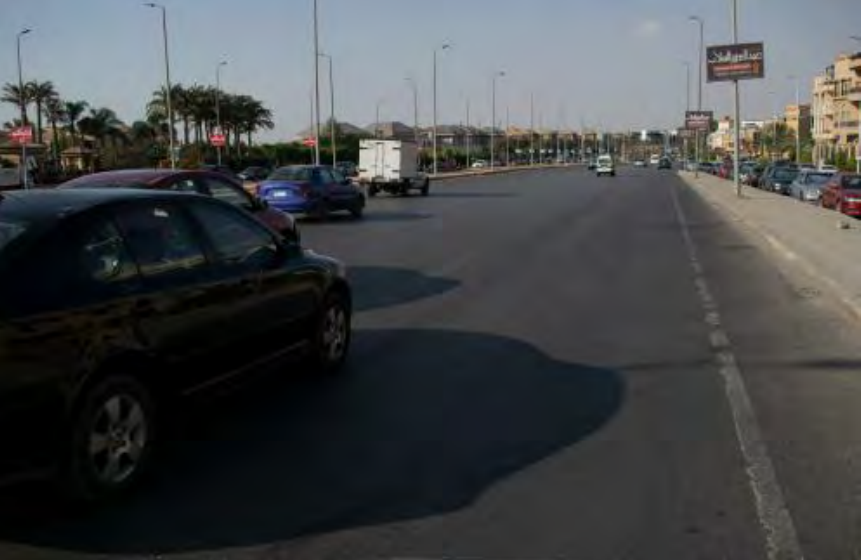
Fig. 29: 90th street before drain installment. (Source: the